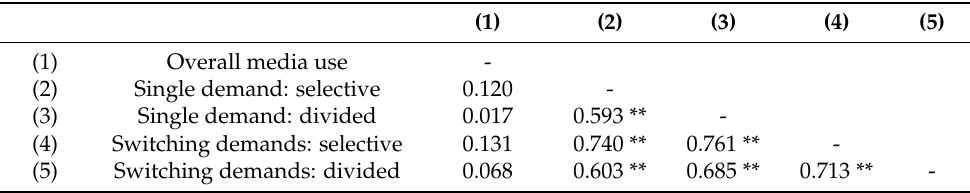
Table 2. Pearson correlations between overall media use in hours per day and attentional subdo- mains.